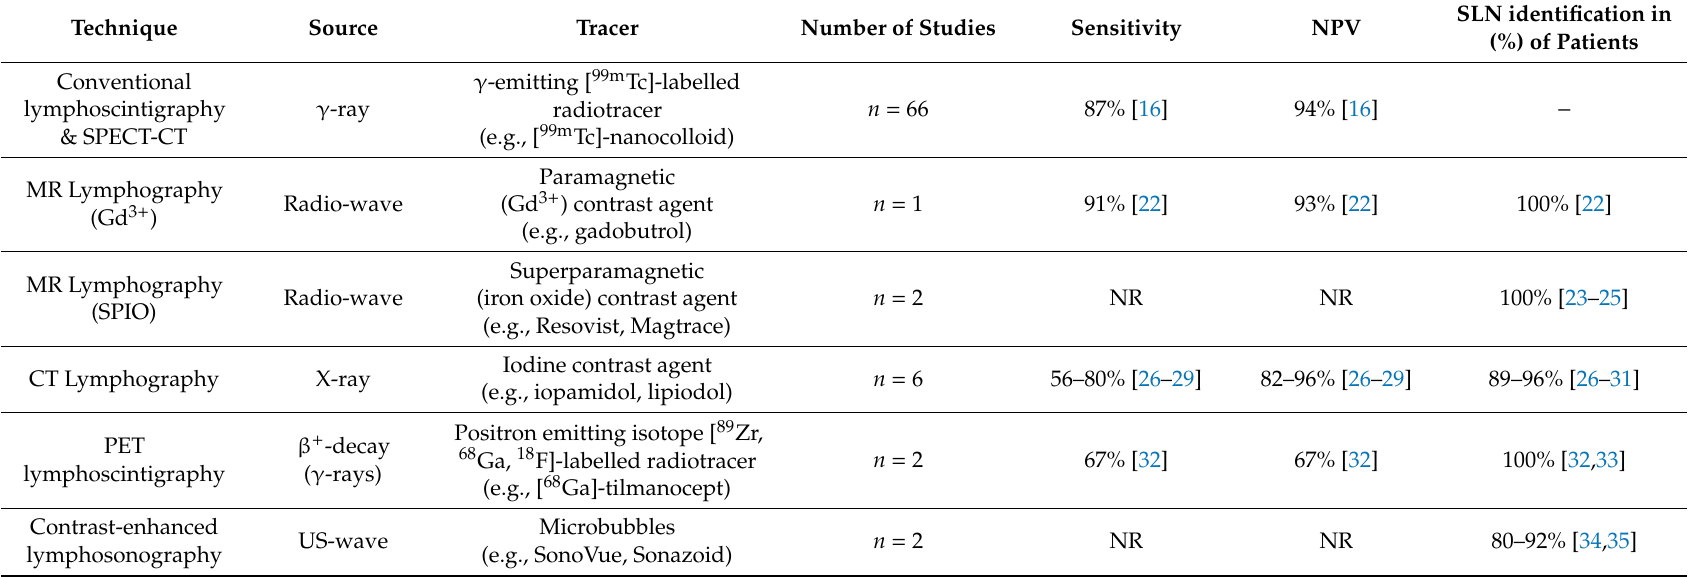
Table 1. Reported diagnostic accuracy and detection rate of sentinel lymph nodes per